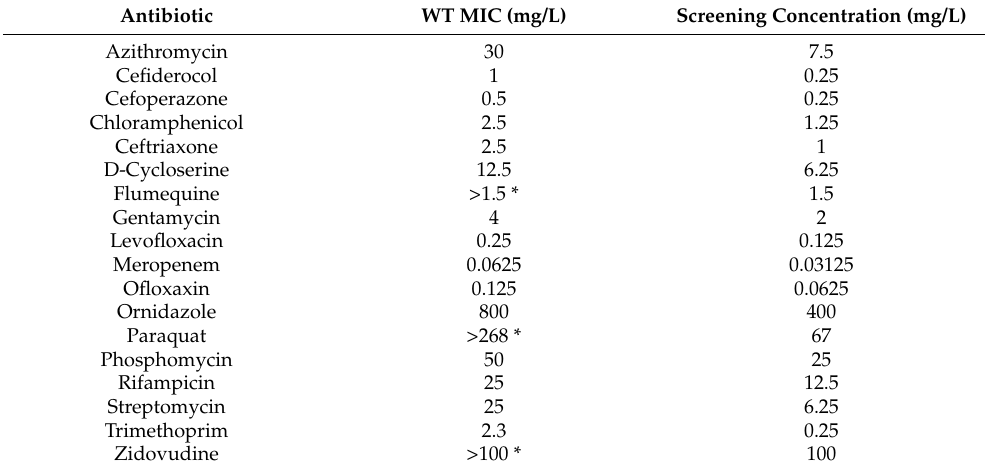
Table 1. Antibiotics and antimicrobials used in this study, with minimum inhibitory concentration (MIC) in the wild-type (WT) strain, and the concentrations used for high-throughput screening experiments are shown.